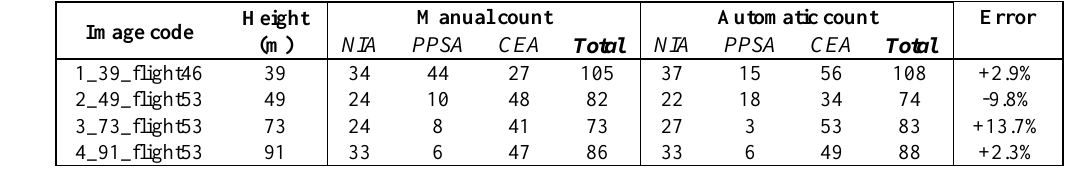
Figure 11: Local maxima (red dots) and isolines (in green) for the upper-right part of the input image. Table 2: Comparison of manual and automatic counts of hippos on the four selected images: NIA (Nearly Immerged Animals), PPSA (Pairs of Polygons corresponding to Single Animals) and CEA (Completely Emerged Animals). Estimation errors are also provided.